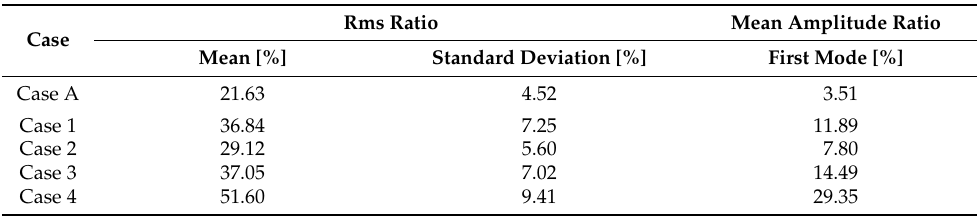
Table 3. Control effectiveness for the five controlled structures, compared with the passive structure: means and standard deviations of the rms reduction ratios (see Figure 6), and mean amplitude reduction ratios at the first mode (see Figure